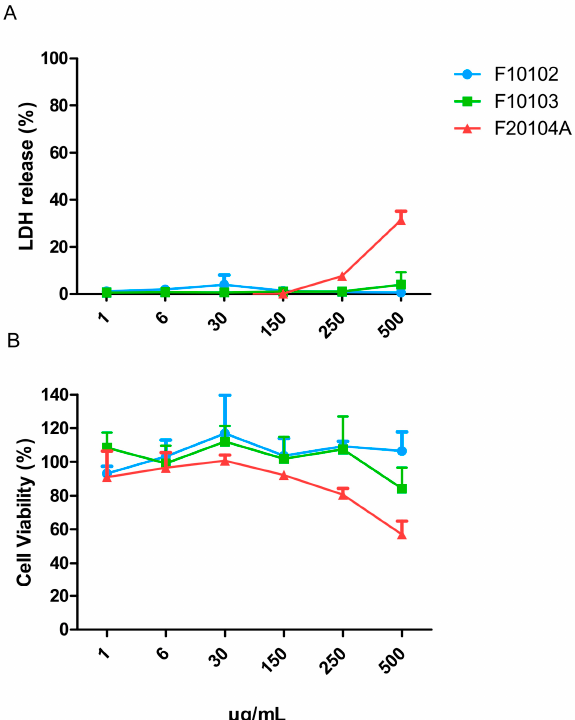
Figure 5 Figure 5. Cell death (% LDH release; A ) and cell viability (% MTT metabolic transformation; B ) of Hep G2 cells exposed to liposomes F10102, F10103 and F20104A for 24 h. The error bars represent the SD of three independent experiments. Negative controls (incubation in medium) and positive controls (cell lysis with Triton) were used as benchmarks.